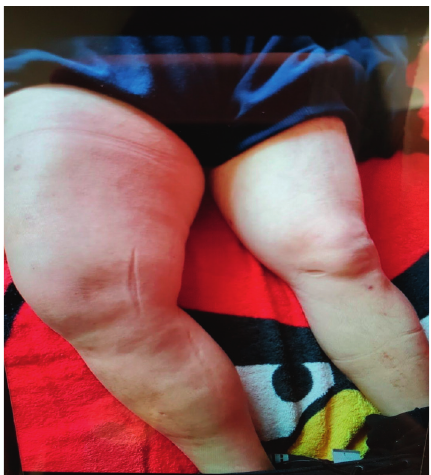
Figure 1: Physical exam showing significant edema of the right thigh.